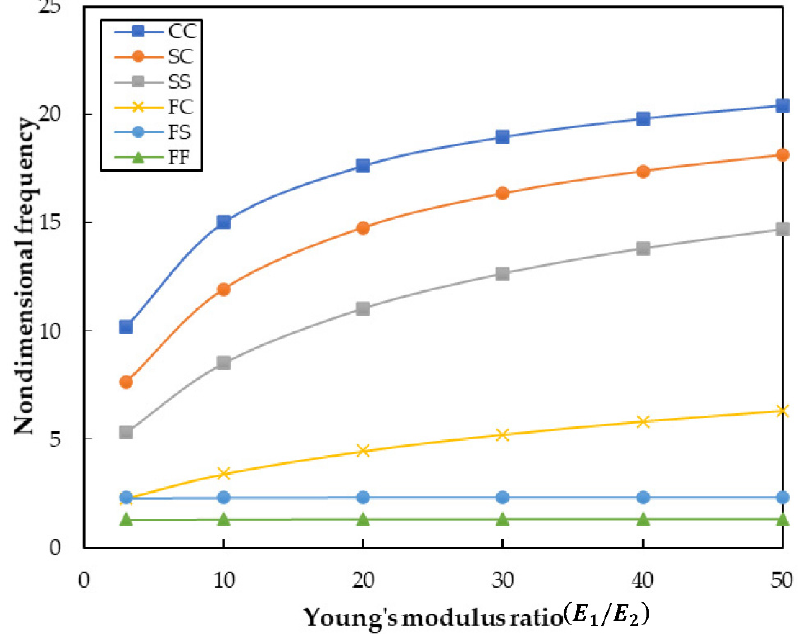
Figure 6. Effect on the non-dimensional frequency of the orthotropic plate for the Levy-type boundary condition with Young’s modulus ratio (cid:4672) (cid:3006) (cid:3117) = 0.5(cid:4673) . (cid:4672) (cid:3029) (cid:3013)